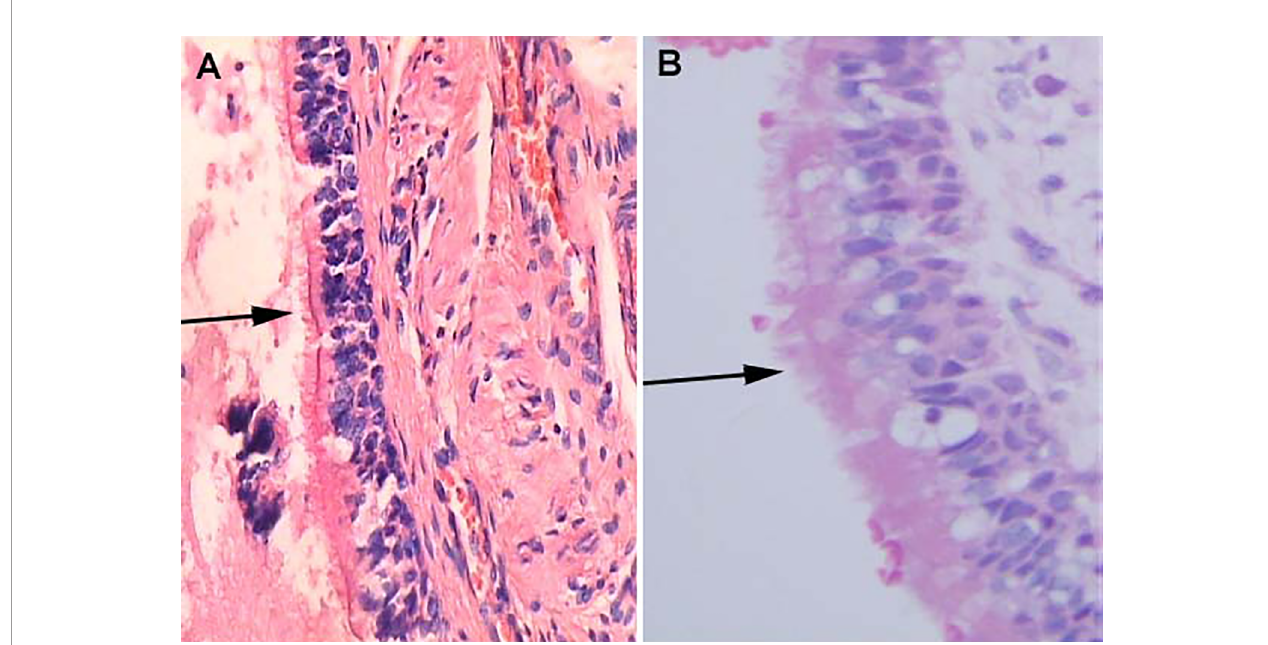
FIGURE 6 | Histological features of Human bronchial epithelium and Rathke ’ s cleft cyst epithelium, H&E stained section. (A) Ciliated bronchial epithelium (arrows) (×100). (B) Cuboidal ciliated epithelium (arrows)